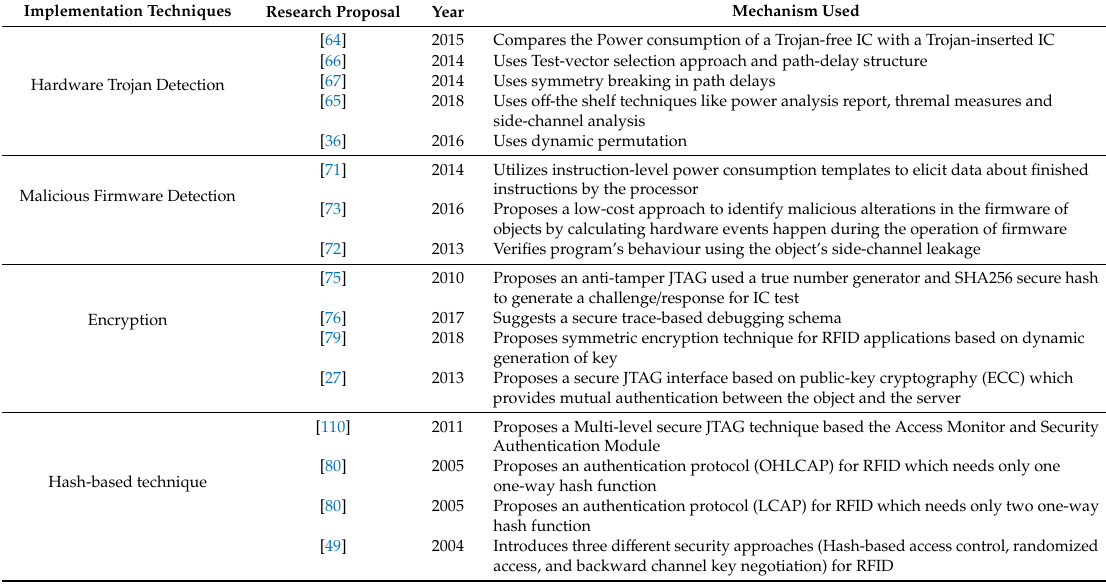
Table 4. A summary of some implementation techniques proposed for edge nodes